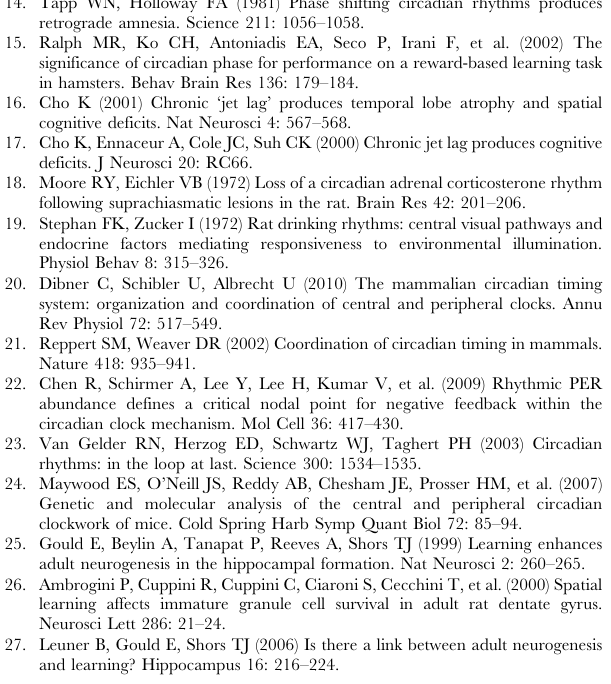
Figure S1 BrdU Experimental Design. Two weeks after recovery from adrenalectomy or ovariectomy, female hamsters were maintained in a fixed 14:10 LD cycle (Control) or an LD cycle that was phase advanced by 6 hrs (Jet Lag), every three days, for 25 days. All animals were injected with BrdU the day following